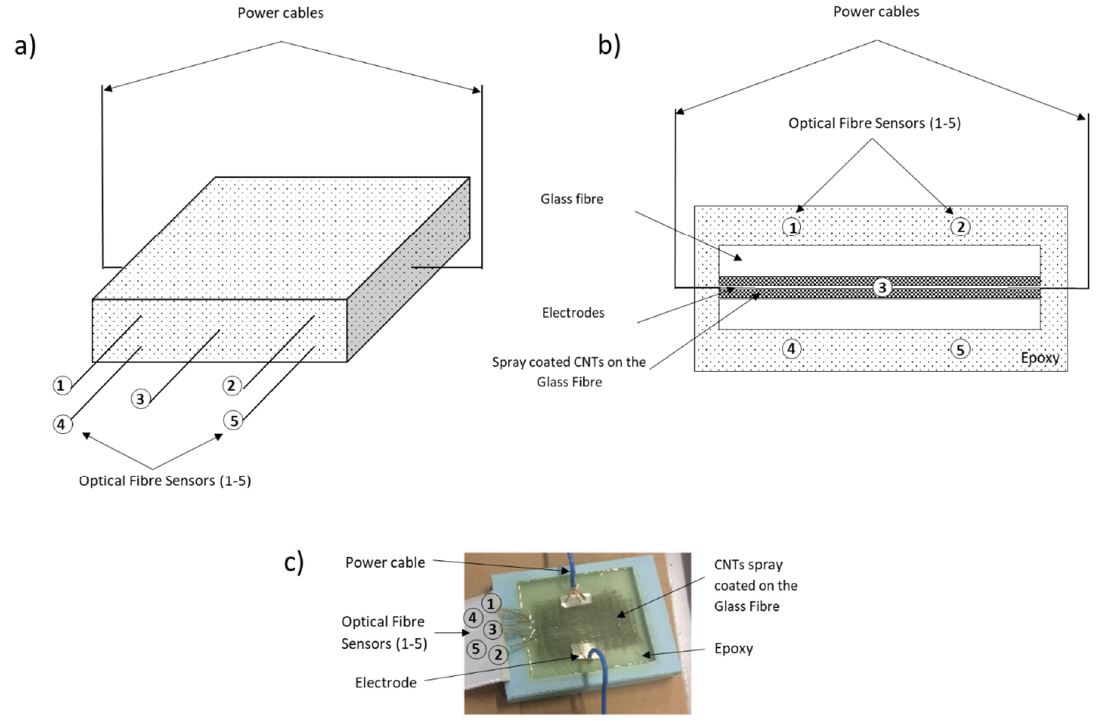
Figure 1. Schematic of the hybrid Glass Fibre Reinforced Polymer (H-GFRP) sample: ( a ) perspective and ( b ) cross-sectional view. ( c ) Optical picture of the H-GFRP sample.